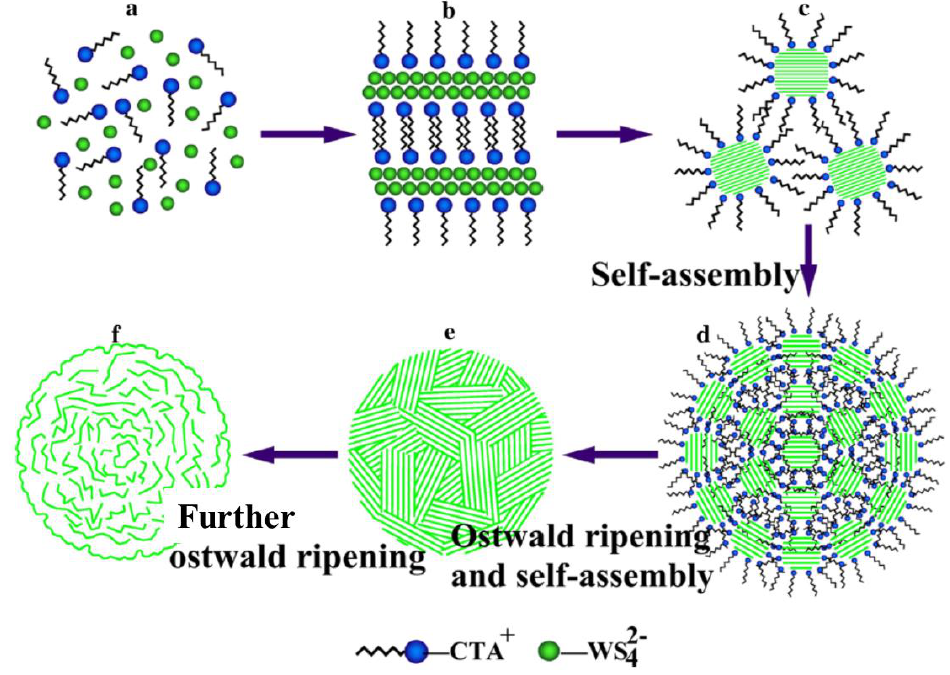
Figure 4. Schematic diagram of the formation process of flower-like WS 2 nanospheres using CTAB as aa surfactant. Reproduced with permission from